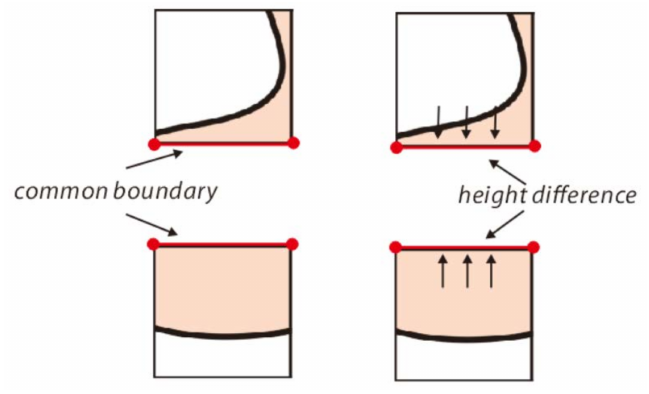
Figure 10. Height difference at a common